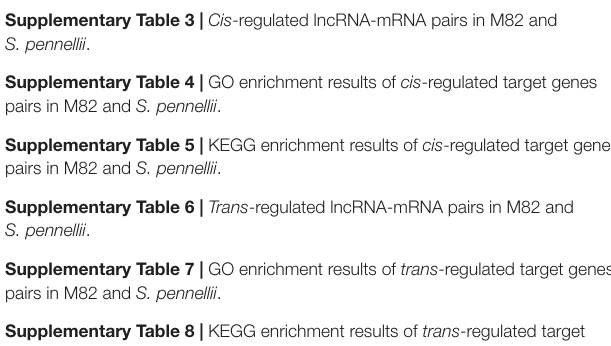
Supplementary Figure 2 | GO enrichment results of trans -regulated target genes pairs in both M82 and S. pennellii . Supplementary Figure 3 | KEGG enrichment results of trans -regulated target genes pairs in both M82 and S. pennellii . Supplementary Figure 4 | The relationships between DE-lncRNAs and DE-mRNAs in M82. Down arrows refer to lncRNAs, rectangles refer to mRNAs. Red represents the up-regulated lncRNA or mRNA. Blue represents the down-regulated lncRNA or mRNA. The lines between lncRNAs and mRNAs represent the targeting relationships. Supplementary Table 1 | RNA-seq data quality assessment. Supplementary Table 2 | Differentially expressed lncRNAs in M82 and Solanum Pennellii